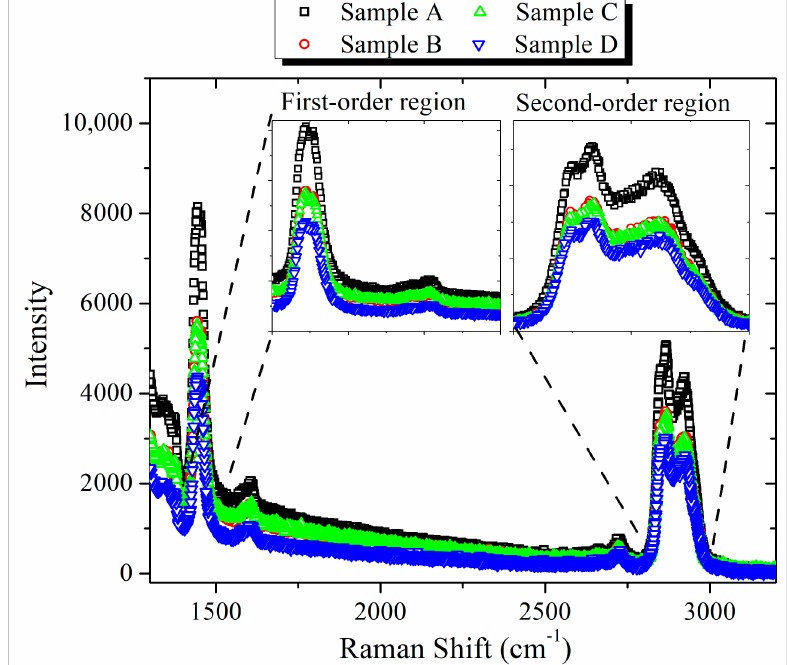
Figure 22. First order and second order region of Raman